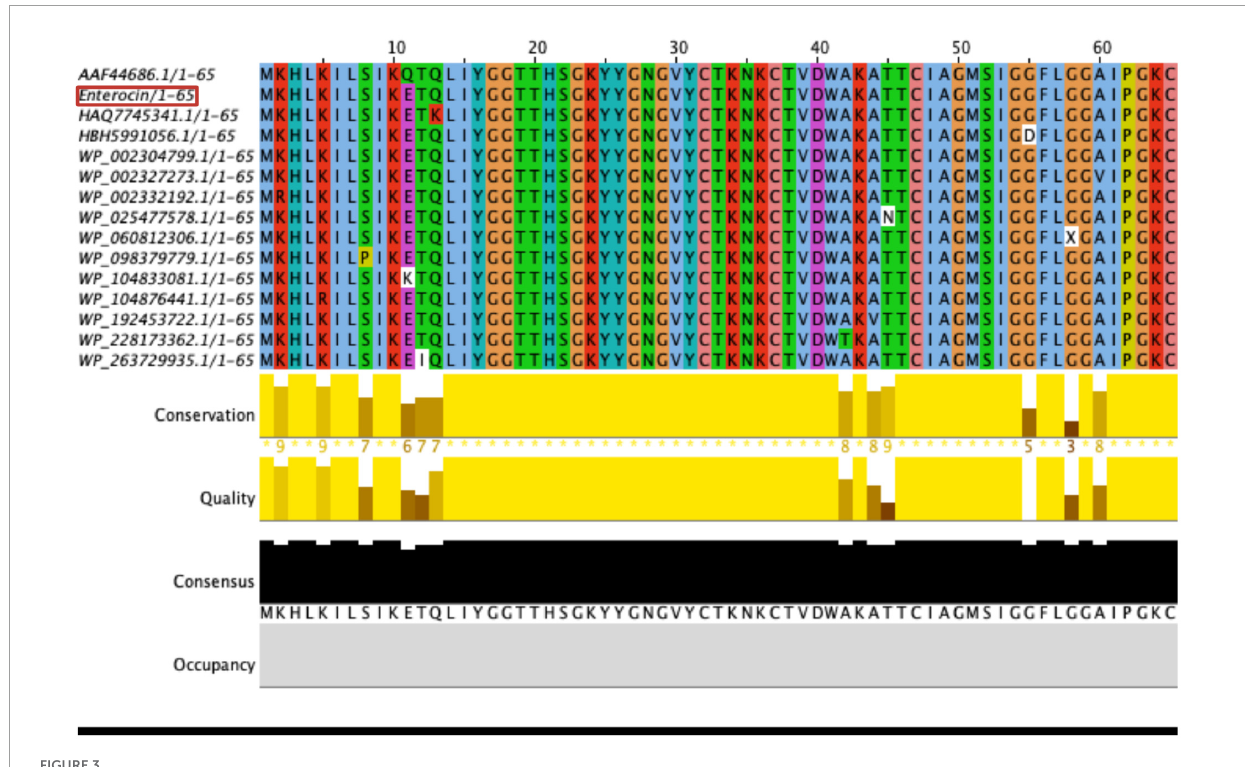
FIGURE3 Multiple sequence analysis (MSA) of E. faecium LR13 enterocin A (red) with other enterocin A using Muscle tool (111).